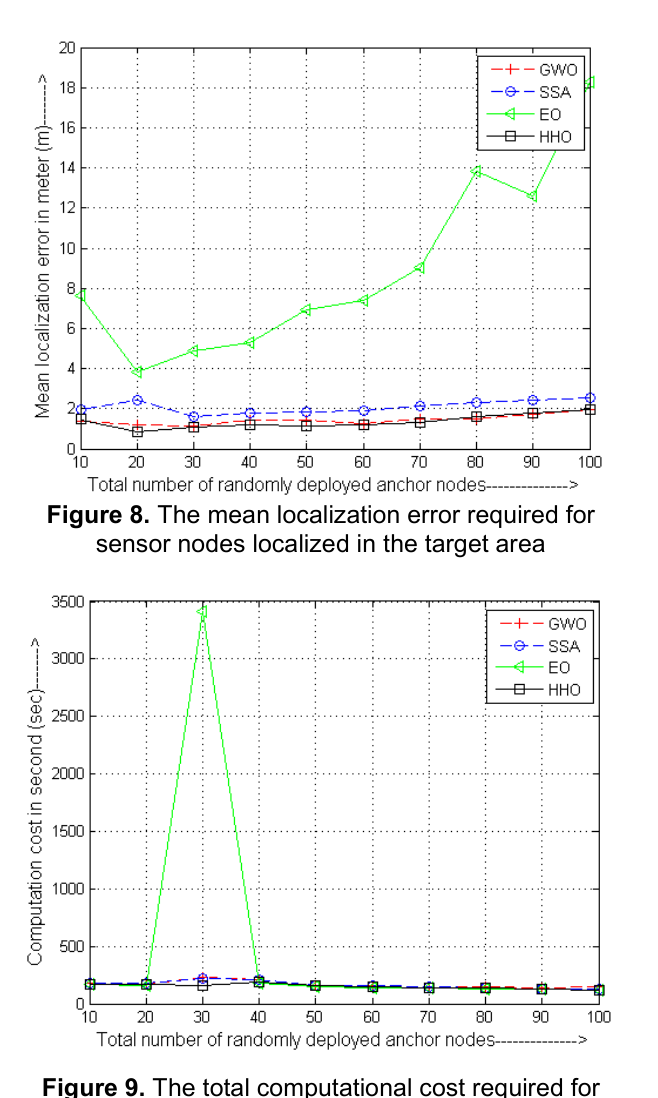
Figure 9. The total computational cost required for sensor nodes localized in the target area.